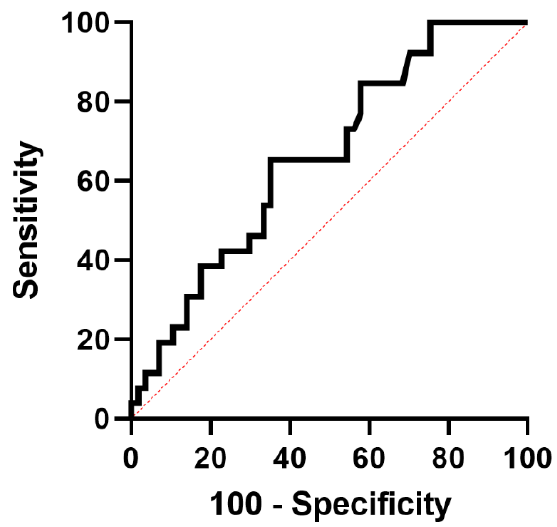
Figure 4. Receiver operating characteristic (ROC) curve for the liver frailty index (LFI) to predict 30-day rehospitalization in patients with liver cirrhosis.